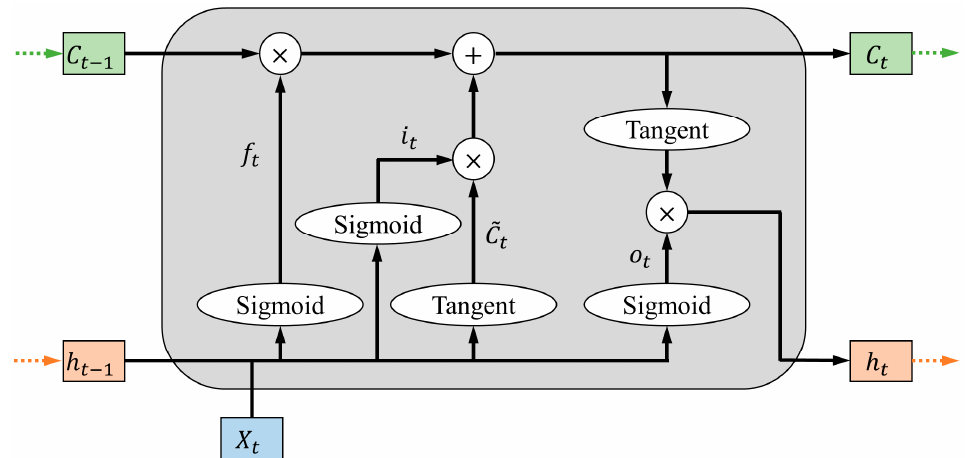
Figure 3. LSTM architecture.